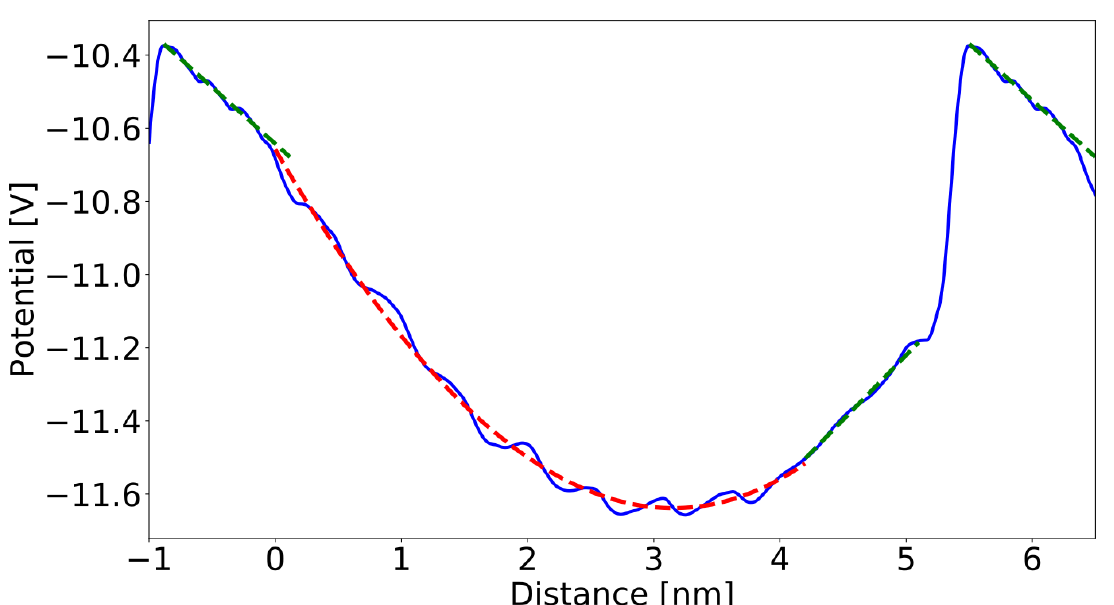
Figure 4. The averaged electric potential profile obtained from ab initio calculations of the structures in Figure 1b. The zero distance is set at the bottom of the cell. Solid blue lines represent averaged potential profiles, red dashed lines — parabolic approximation in the graded regions; green dashed lines — linear approximation in the uniform regions.